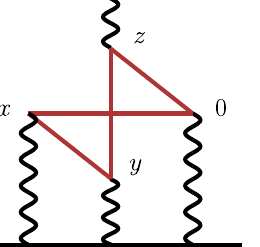
Fig. 2 Wick contractions for the connected contribution. Each diagram represents two contractions with quark flow in opposite